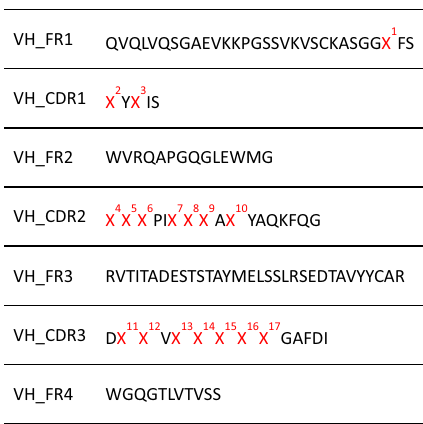
Table 1. Amino acid design of F02 heavy chain library. X indicates diversified position. X 5 : I/L/V, X 8 : G/S, X 12 and X 16 : A/P, X 17 : H/R, Other positions: 20 amino